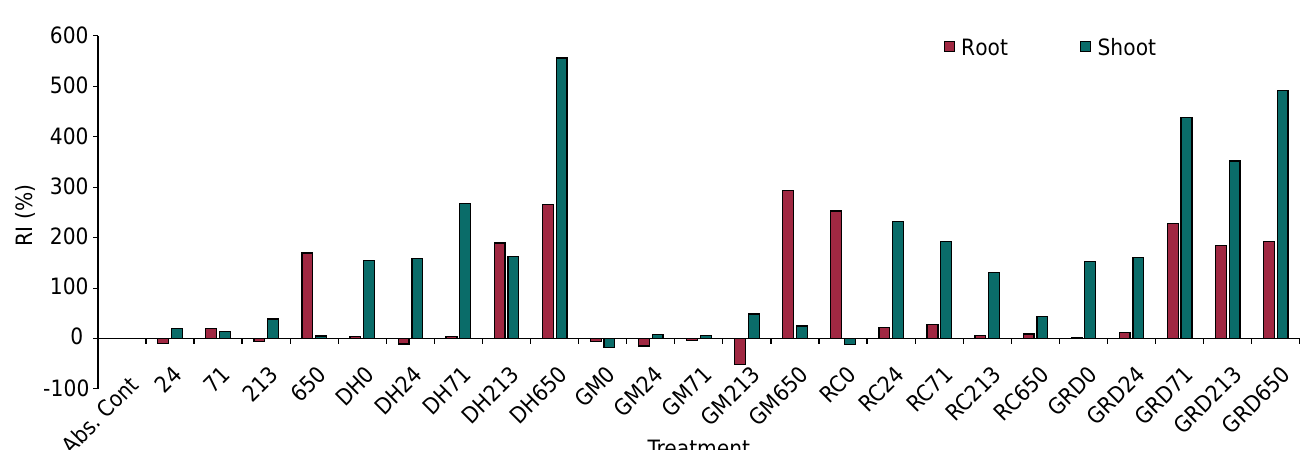
(1) GRD: AMF mix of the three arbuscular mycorrhizal fungi. (2) Estimated by subtracting the area under the curve of the treatment without inoculation from the area under the curve of the treatments with inoculation. (3) Estimated by the definite integral of the curve of the treatments without inoculation. (4) Estimated by the relation between the mycorrhizal benefit and P benefit.